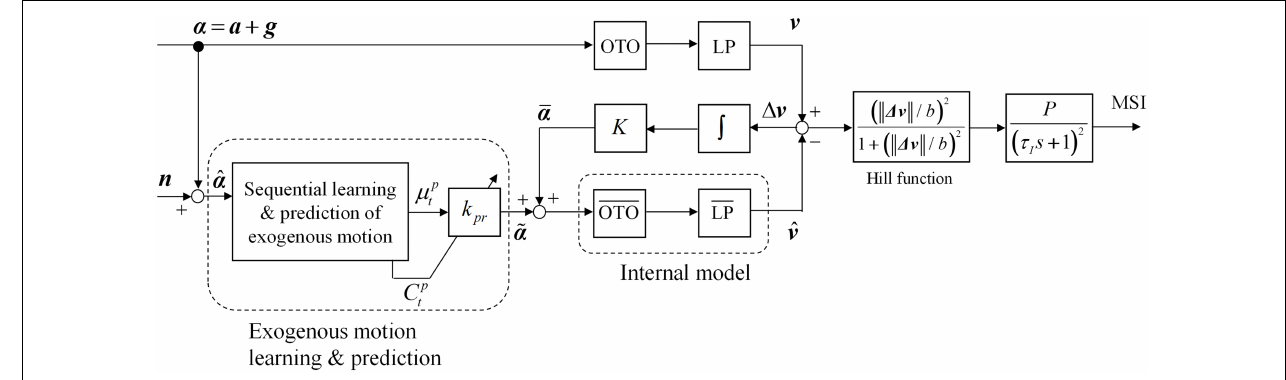
FIGURE 3 | Block diagram of sensory conflict theory based on the internal model